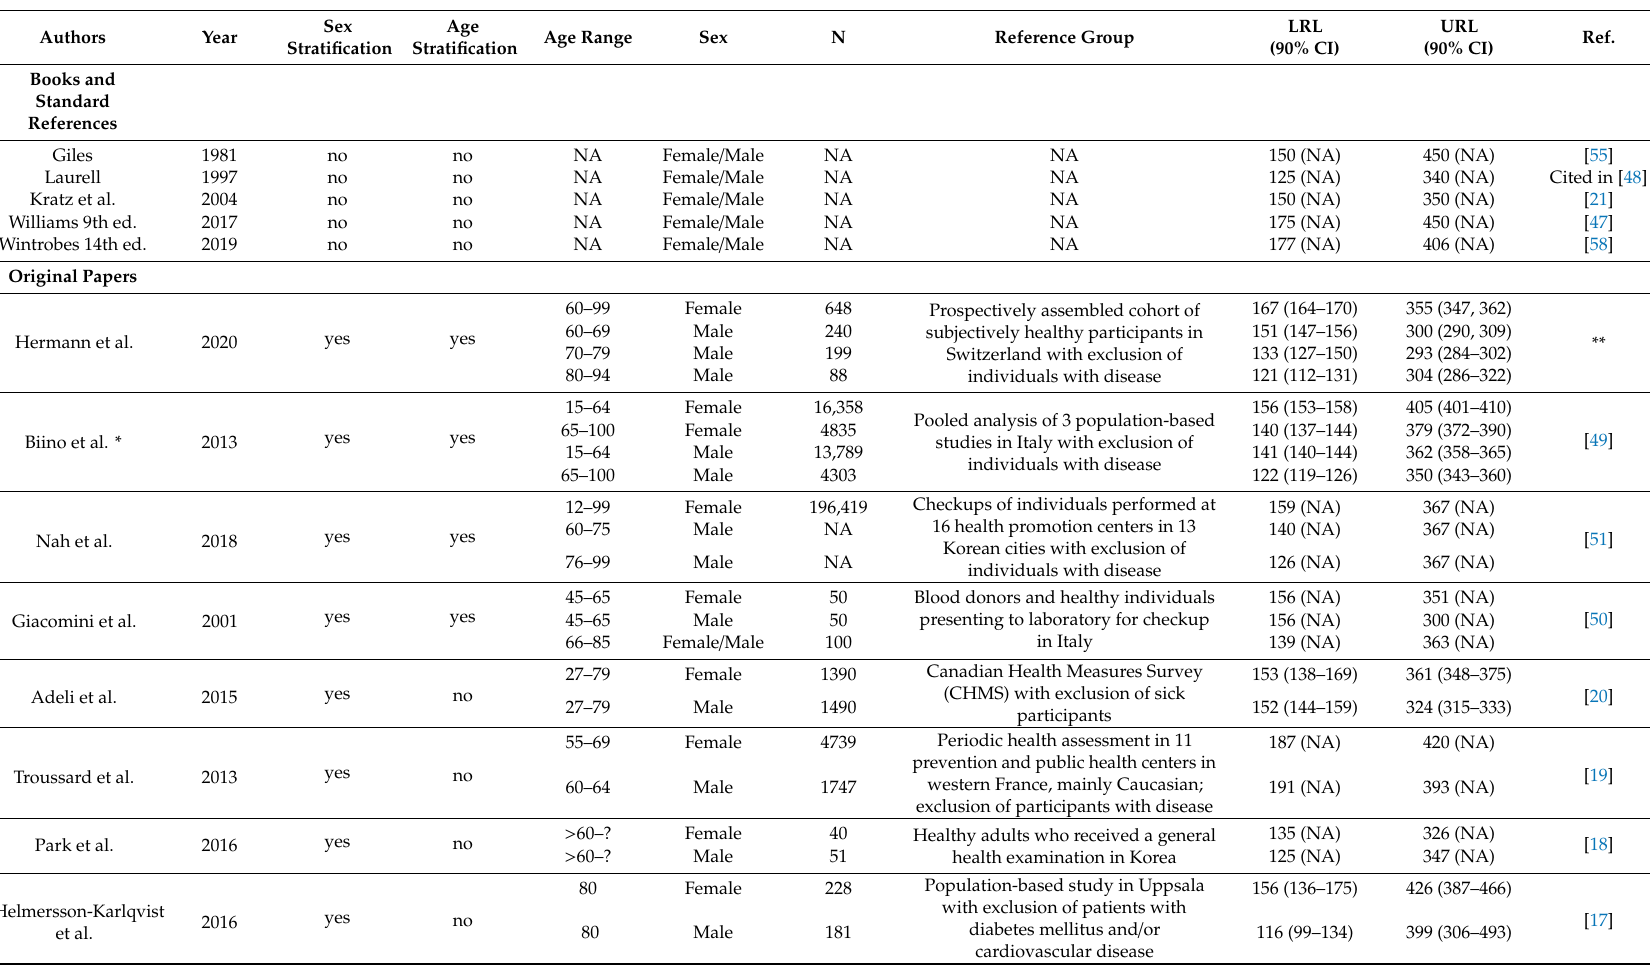
Table 6. Systematic tabulation of direct evaluations of reference intervals for seniors. Median of LRL for females is 156 × 10 9 / L and for males it is 140 × 10 9 / L; median of URL for females is 396 × 10 9 / L and for males it is 367 × 10 9 /